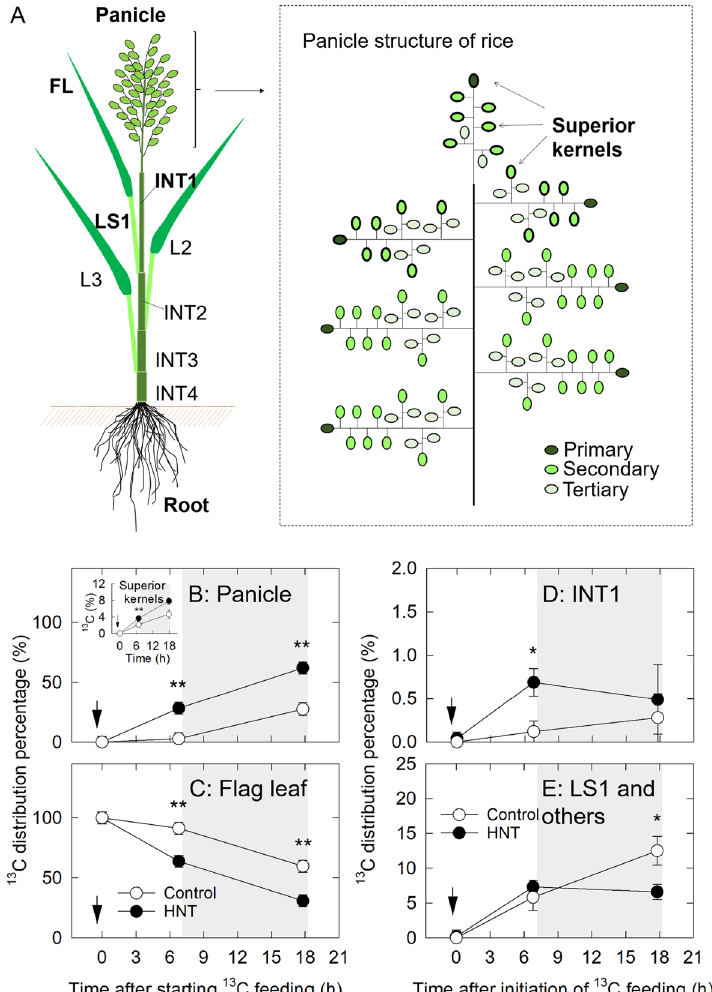
Figure 2. ( A ) Diagram of rice plant (left) and rice panicle structure (right). Time course of changes in 13 C distribution in the panicle ( B ); in the flag leaf ( C ); in the INT1 ( D ) and in flag leaf sheath and others (determined as pooled organs with these tissues) ( E ). In panicle structure in ( A ), superior kernels attached to the same position, where the on-site cell metabolomics was conducted, were displayed with thick lines. Changes in 13 C distribution in the superior kernels were also shown (see inset in B ). The plants were labeled with 13 CO 2 for 30 min from the flag leaf at 8 DAH at day time, as indicated by the arrow in ( B – E ). White and black circles indicate the control and HNT treatments, respectively. Gray areas indicate the HNT treatment. FL, flag leaf; INT1 , first internode; LS1, first leaf sheath; L2 , second leaf blade. Each point is the mean ± SE of four samples from different plants. * and ** show p < 0.05 and 0.01 by t -test,